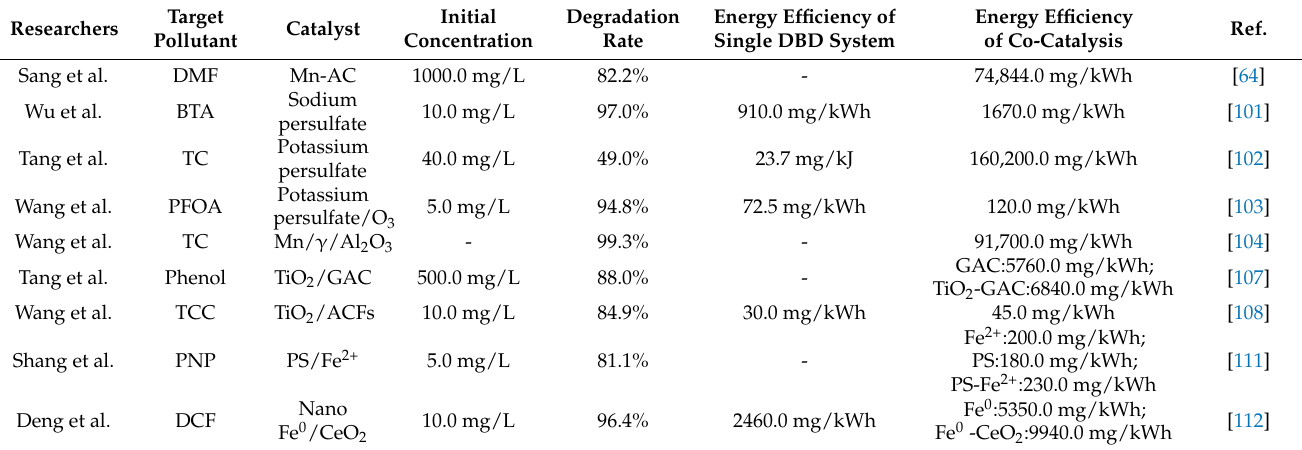
Table 6. Energy efficiency of DBD technologies for organic wastewater removal in different